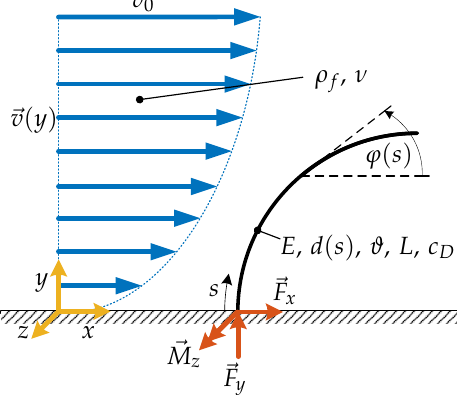
Figure 3. The mechanical/geometrical properties of the beam are described as follows: E as Young’s Modulus, d ( s ) as diameter depending on the arclength s , ϑ as ratio of base diameter and tip diameter, L as length, c D as drag coefficient and ϕ as slope to the respective x -axis. The support reactions are F x , F y , M z and the internal forces are q x and m z , see (7). The flow velocity profile is characterized by v ( y ) and the maximum flow velocity v 0 whereby the fluid properties are given by the density ρ f and the kinematic viscosity ν